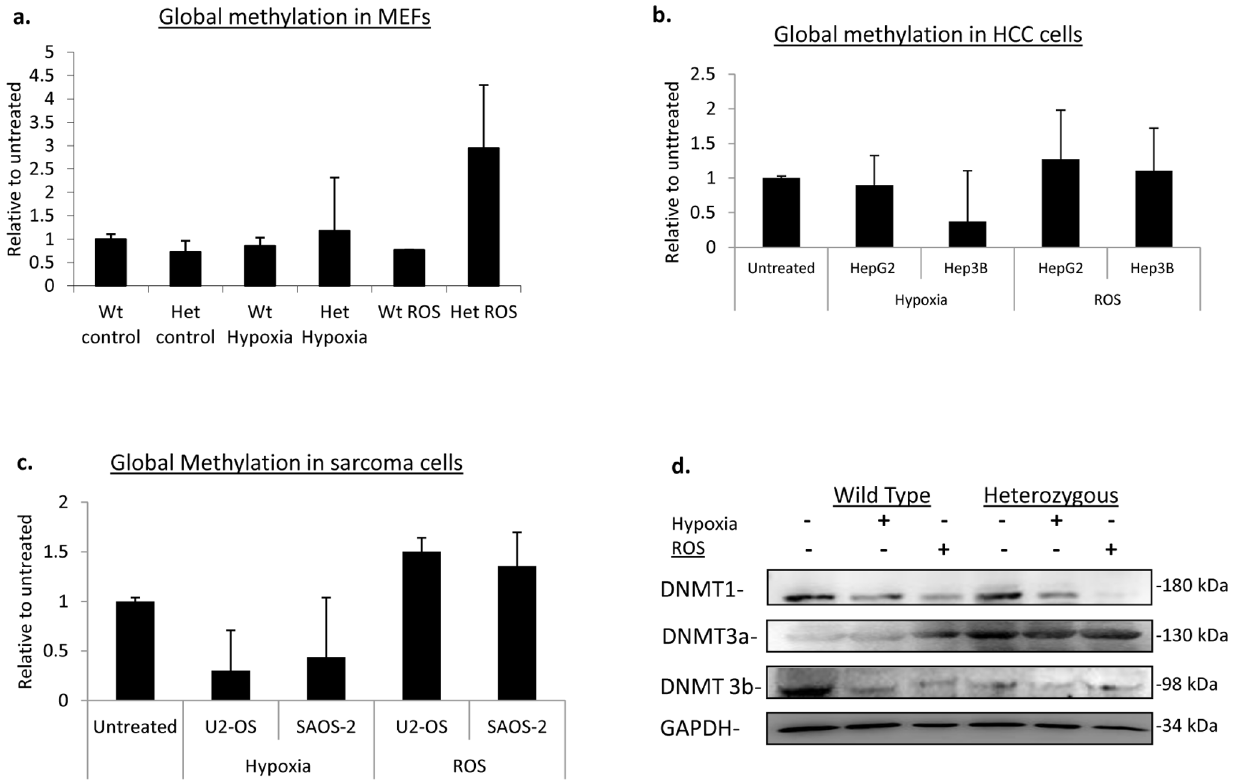
Figure 6. Analysis of global methylation in MEFs, HCC and osteosarcoma cells and DNMTs levels in MEFs. An ELISA-based global methylation assay was performed to determine changes in global methylation levels due to oxidative stress as a result of hypoxia and ROS exposure. The histograms are representative of three independent experiments and the error bars depict the + / 2 SD. (a) In MEFs the values have been normalized to the untreated wild-type cells. (b,c) The values have been normalized to the respective untreated samples. (d) Western blot analysis was used to determine the levels of the DNMTs from whole cell lysates extracted from untreated ( 2 ) and treated ( + ) MEF cells.